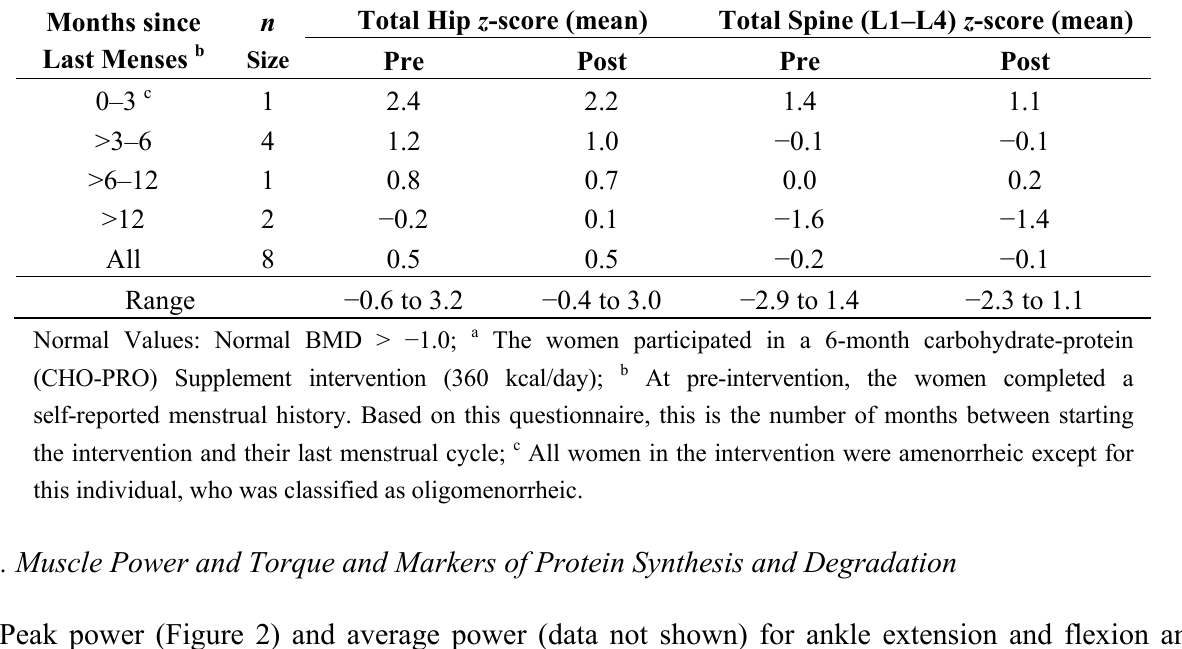
Table 5. Bone status (BMD z -score) in women with ExMD before and after a 6-month dietary intervention by months since last menses a